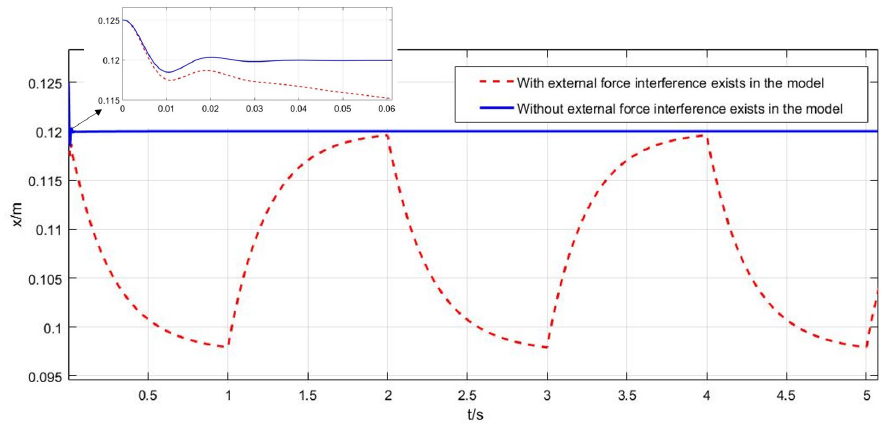
Figure 4. The x-direction position curve with or without